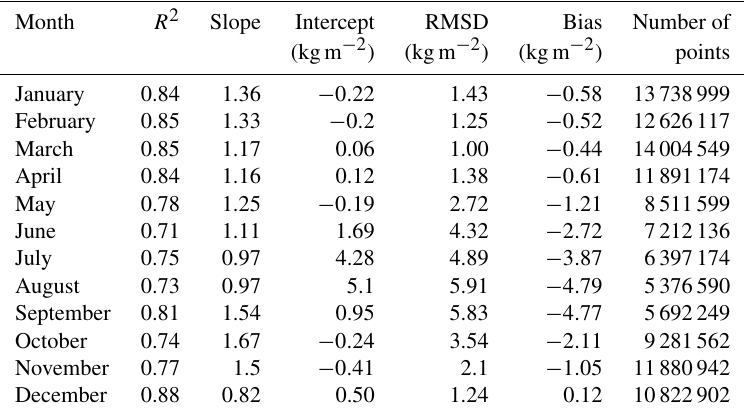
Table 5. Parameters for linear regression for monthly AMSU-B and ERA5 intercomparison. Month R 2 Slope Intercept RMSD Bias Number of (kgm − 2 ) (kgm − 2 ) (kgm − 2 ) points January 0.84 1.36 − 0 . 22 1.43 − 0 . 58 13738999 February 0.85 1.33 − 0 . 2 March